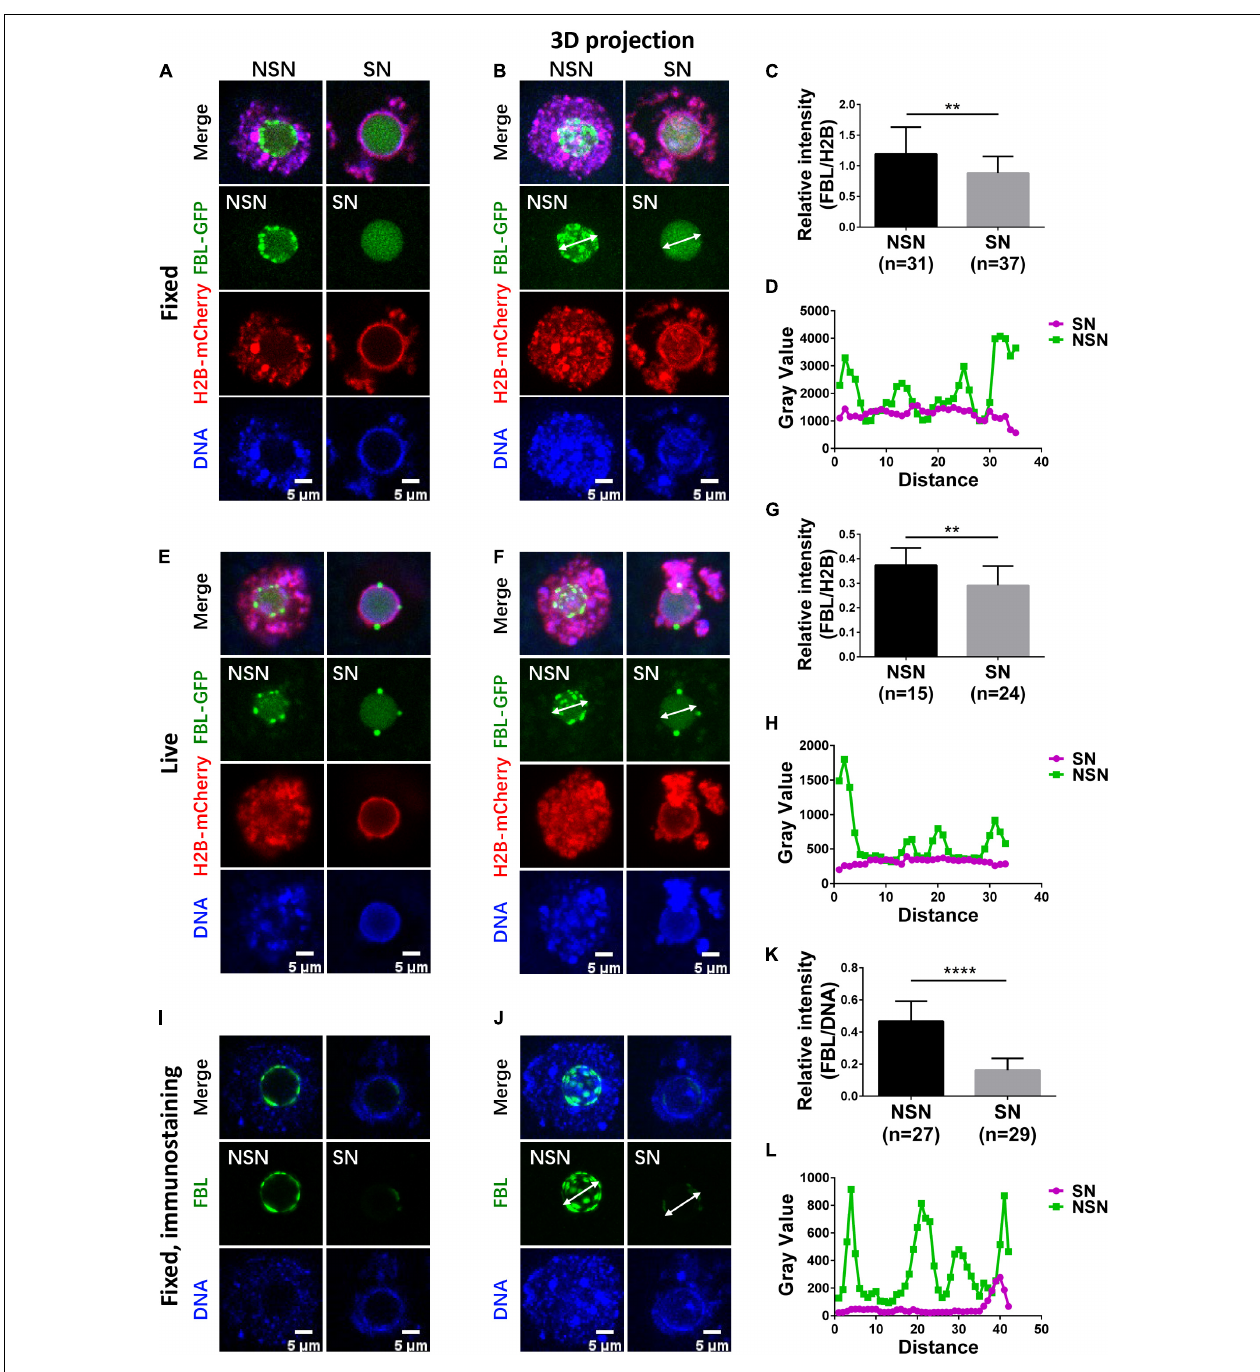
FIGURE 1 | Organization of FBL clusters in NSN and SN oocytes. (A,B) FBL exhibits a clustered distribution pattern in fixed NSN GV oocytes. The clusters decrease significantly in fixed SN GV oocytes. Representative z section (A) and 3D projection (B) confocal images of exogenously expressed FBL–GFP and H2B-mCherry in oocytes are shown. Scale bar = 5 µ m. (C) Bar graph shows relative FBL signal intensity to H2B signal intensity in fixed NSN and SN GV oocytes. N = 68. ** P < 0.01. (D) The intensity distribution of FBL was measured along the arrow lines drawn on the images in (B) . Green, NSN; purple, SN. (E,F) FBL distribution patterns in live NSN and SN GV oocytes. Representative z section (E) and 3D projection (F) confocal images of exogenously expressed FBL–GFP and H2B-mCherry in oocytes are shown. Scale bar = 5 µ m. (G) The bar graph shows relative FBL signal intensity to H2B signal intensity in live NSN and SN GV oocytes. N = 39. ** P < 0.01. (H) The intensity distribution of FBL was measured along the arrow lines drawn on the images in (F) . Green, NSN; purple, SN. (I,J) FBL distribution patterns were confirmed with anti-FBL in fixed NSN and SN oocytes. Representative z section (I) and 3D projection (J) confocal images of endogenous FBL localization are shown. Scale bar = 5 µ m. (K) The bar graph shows relative anti-FBL signal intensity to DNA signal intensity in fixed NSN and SN GV oocytes. N = 56. **** P < 0.0001. (L) The intensity distribution of anti-FBL was measured along the arrow lines drawn on the images in (J) . Green, NSN; purple, SN.